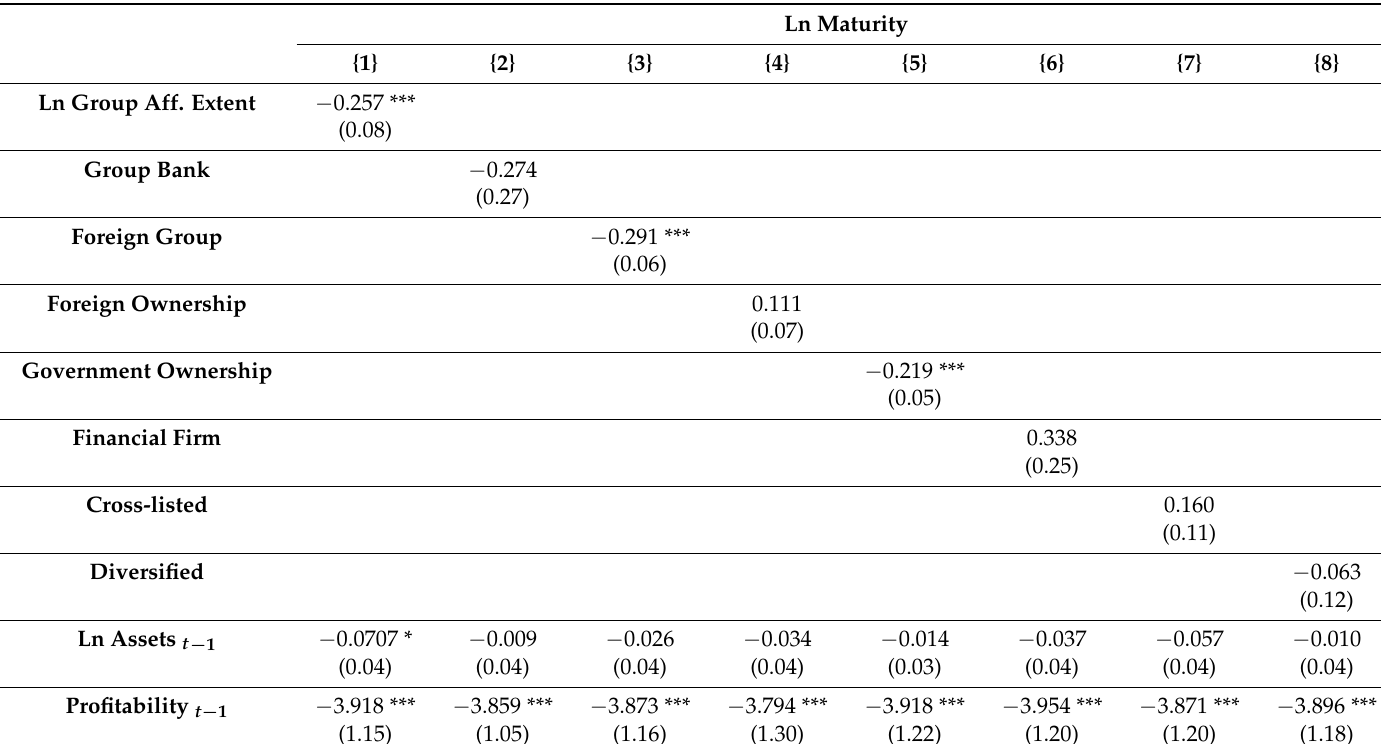
Table 5. OLS regressions of maturity on Group Affiliation Extent, Group Bank, Foreign Group, Foreign Ownership, Government Ownership, Financial Firm, Cross-listed, Diversified, and Borrower and Loan Characteristics. Table 5 presents the pooled ordinary least squares (OLS) regression results of ln (Maturity) on Group Affiliation Extent, Group Bank, Foreign Group, Foreign Ownership, Government Ownership, Financial Firm, Cross-listed, Diversified and Borrower and Loan Characteristics. Group Affiliation Extent is calculated based on percentage of group ownership in borrower firms (0% indicates that there is no group association, and 100% means that the associated group owns all the firm’s shares). Binary variables indicate whether a Group Bank, Foreign Ownership, Government Ownership, or Foreign Group Affiliation exist, whether the borrower is Focused or Diversified, whether the firm is Financial Firm, and whether it is Cross-listed. Control variables include firm and loan characteristics, and loan type, year, and industry dummies. Robust standard errors are reported in parentheses. Each model is clustered at the group level to control for possible group fixed effects. *, **, and *** represent significance levels of 10%, 5%, and 1%